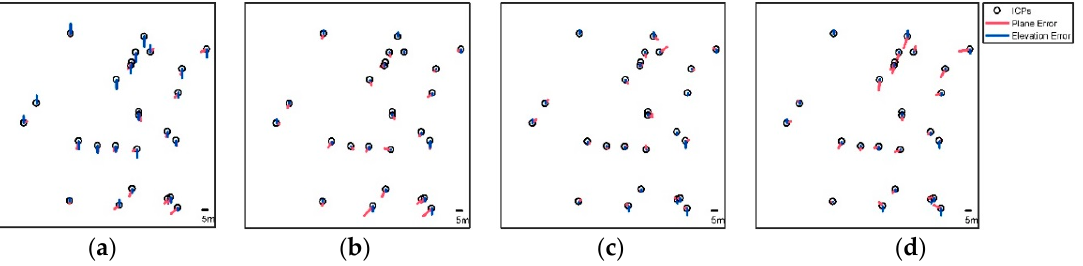
Figure 5. Residual distributions of ICPs of free network adjustment for the Qiqihar area: ( a ) Scheme 1; ( b ) Scheme 2-F; ( c ) Scheme 2-N; and ( d ) Scheme 2-B.